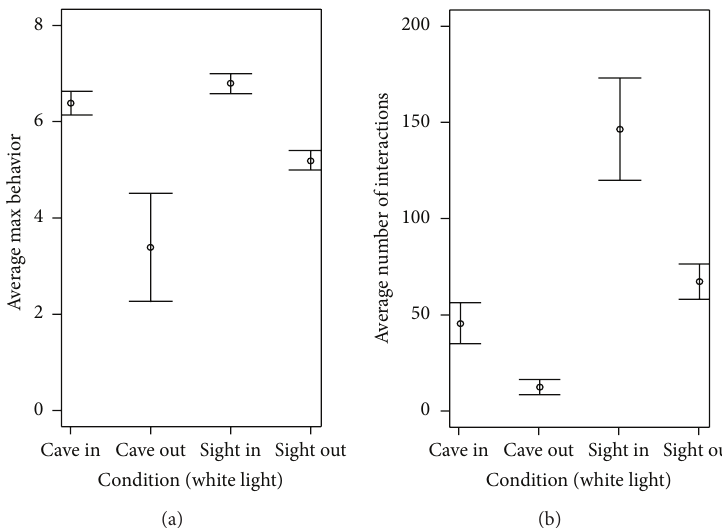
Figure 5: Comparison of cave and sighted crayfish in and out of water in low/white light. (a) The mean number of maximum behavior (± SEM ) is plotted for the four conditions. There is a significant difference between in and out of water for both species. (b) The mean number of total interactions (± SEM ) for the four conditions. There is also a significant decrease in both species between in and out of water in low